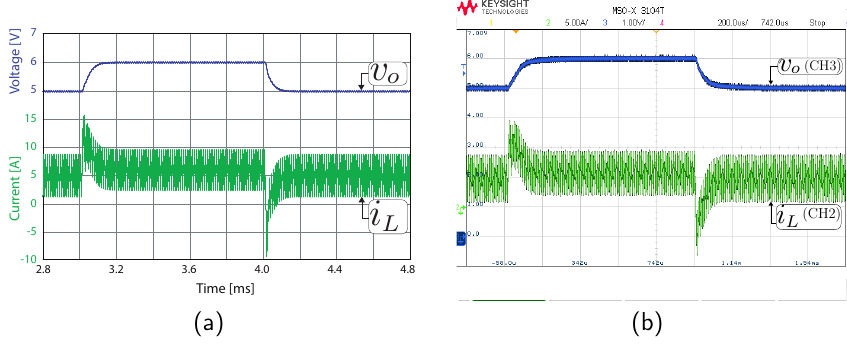
Figure 7. Voltage regulation waveforms corresponding to reference changes from 5 V to 6 V and again to 5 V ( w = 0.5): ( a ) Simulation; ( b ) Experimental measurement. −